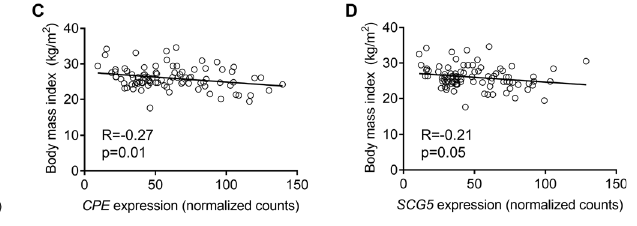
PCSK1N . Data extracted from GSE50244. n =89. Source data are provided as a Source Data fi